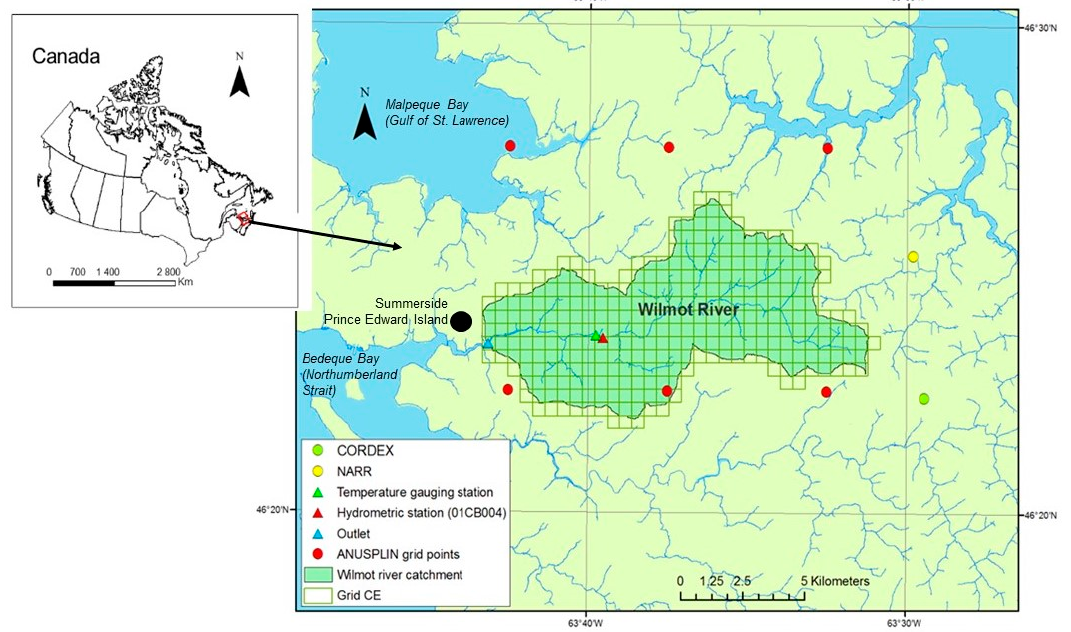
Figure 2. Wilmot River drainage basin with the CEQUEAU whole square grid. ANUSPLIN ( red ), CORDEX ( green ) and NARR ( yellow ) grid point locations are also shown. Temperature monitoring and hydrometric station locations are also shown. The city of Summerside and adjacent estuaries are indicated, the larger bodies of water into which those bays flow is indicated in